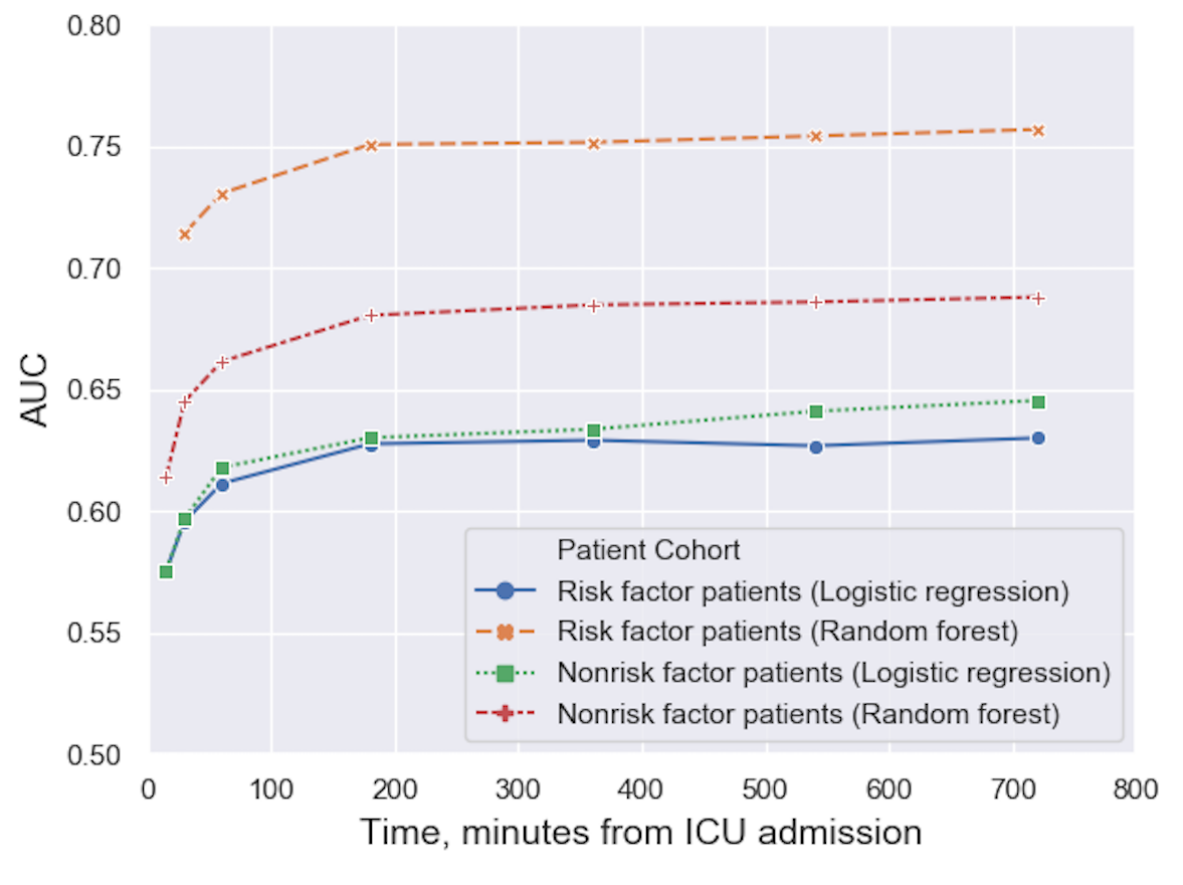
Figure 4. Predication AUC for risk factor and nonrisk factor patients with variable vital signs extraction time windows from 15 minutes to 720 minutes using only vital signs as model inputs. The x-axis represents the total number of minutes from ICU admission that vital signs were extracted from the database, meaning at higher time values more data was extracted. AUC: area under receiver operating characteristic curve; ICU: intensive care unit.